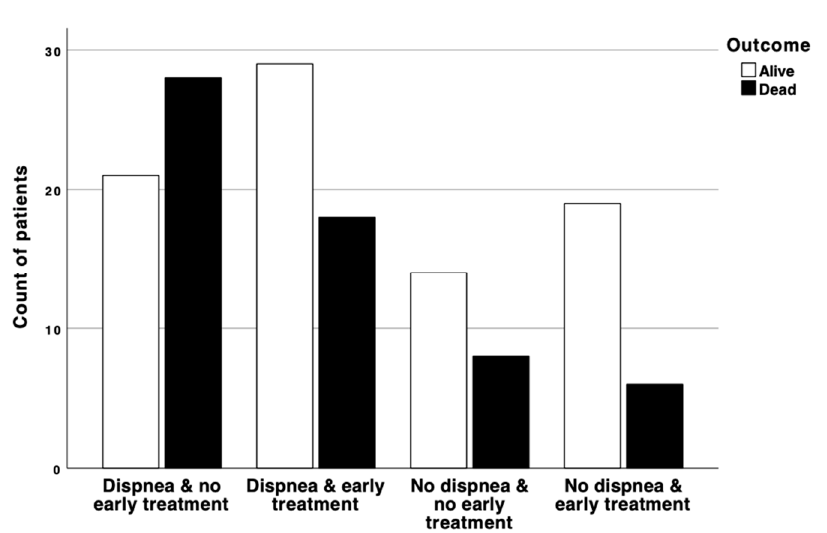
Figure 3. Comparison of frequency of alive (white column) and dead (black column) patients in four categories: dyspnea with late treatment; dyspnea with early treatment; no dyspnea and late treatment, and no dyspnea and early treatment.